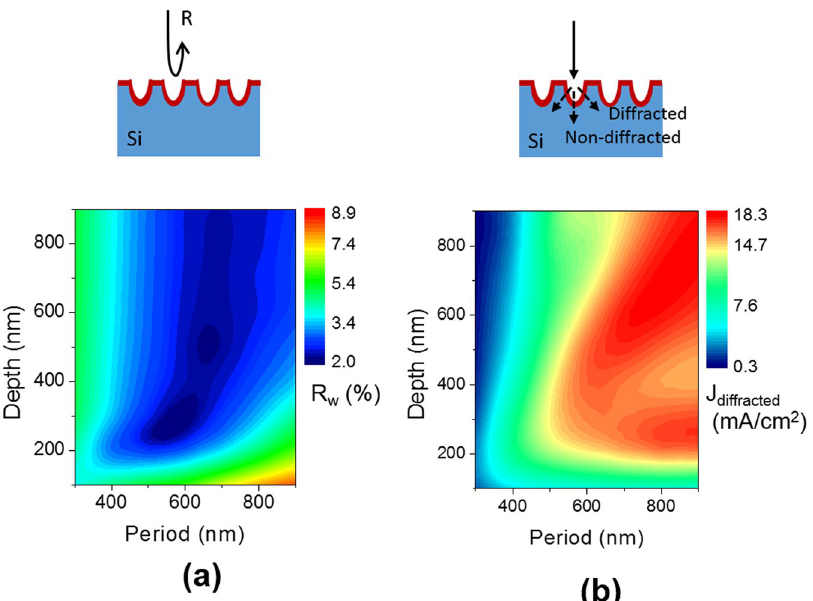
Figure 6. ( a ) RCWA simulated results of weighted total reflectance of the Si nanohole arrays with varying periods and depths. ( b ) Maximum photocurrent of the Si nanohole arrays with varying periods and depths. Only diffracted light in the wavelength from 800 nm to 1200 nm is considered to contribute to photocurrent. The thickness of the Si wafers is assumed to be semi-infinite for both of the